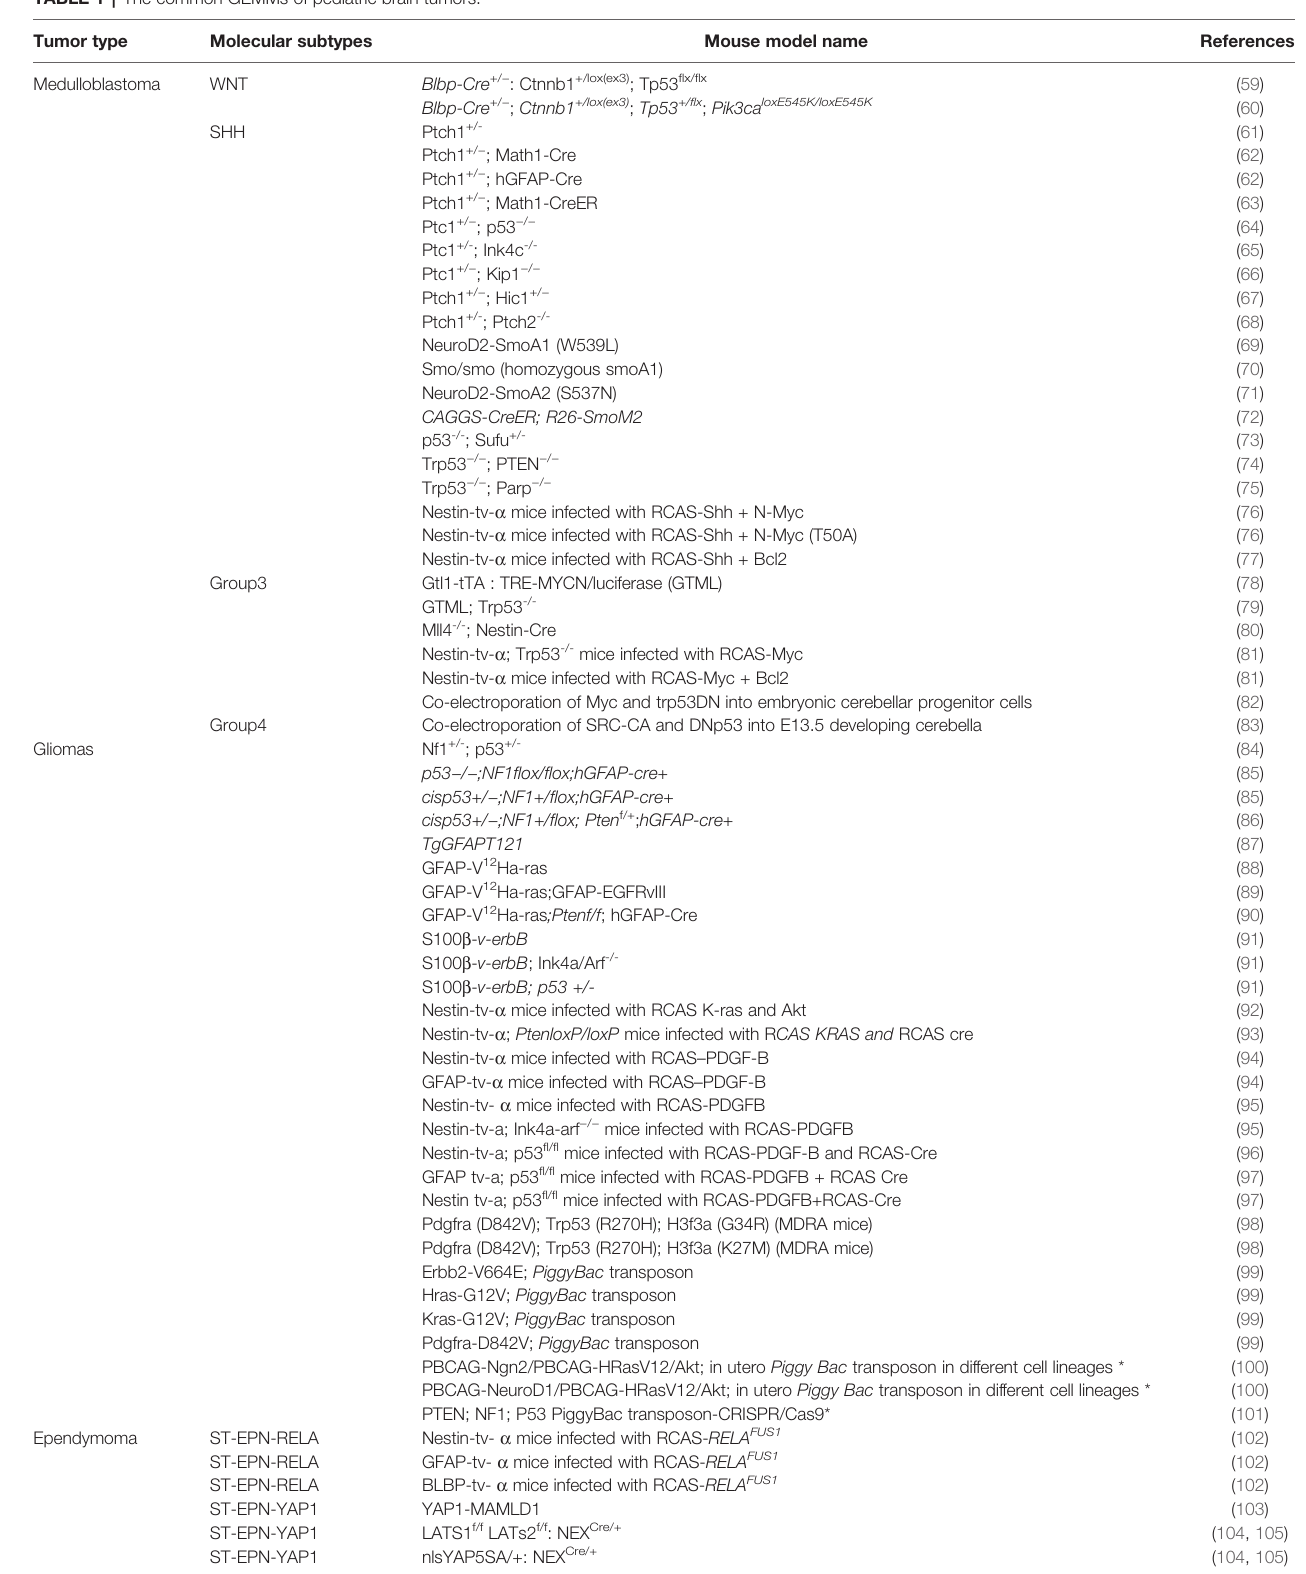
TABLE 1 | The common GEMMs of pediatric brain